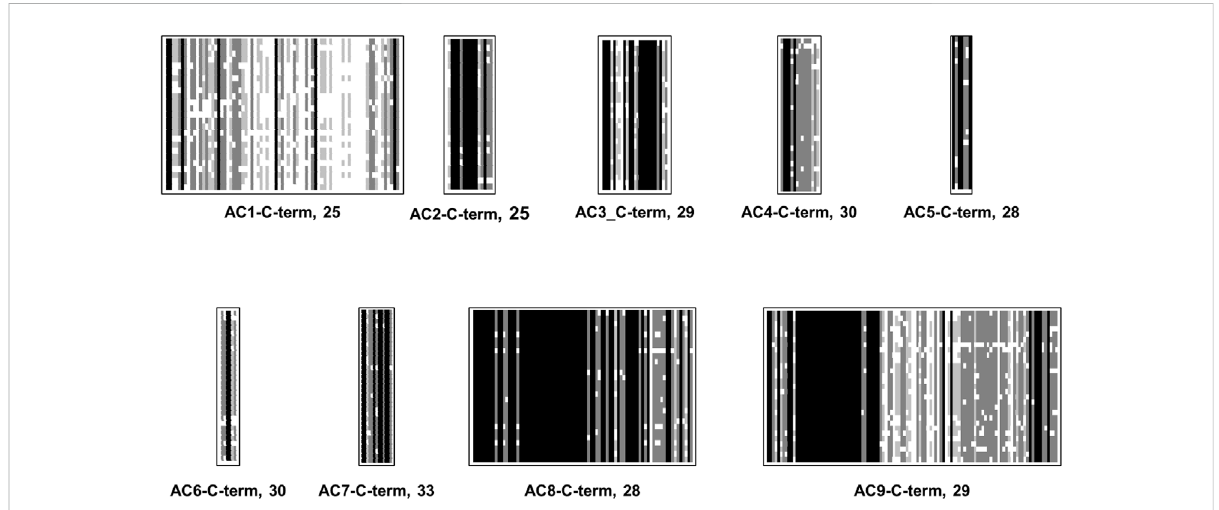
FIGURE 9 AlignmentofC-terminiofmammalianmACisoforms.ForeachmACisoformthenumberofanalyzedproteinsisindicated.mAC1:C-terminusis 65 aa – 75 aa long. mAC2: C-terminus is uniformly 25 aa long. mAC3: C-terminus is 25 aa long. mAC4: length is 15 aa. AC5: length invariably 7 aa. mAC6: length 6 aa – 7 aa. mAC7: 13 aa long; mAC8: highly conserved with a length of 81 aa. mAC9: uniform length of 110/111 aa ’ s. Shading: black, invariant; dark grey, conserved; light grey, slightly conserved; white: